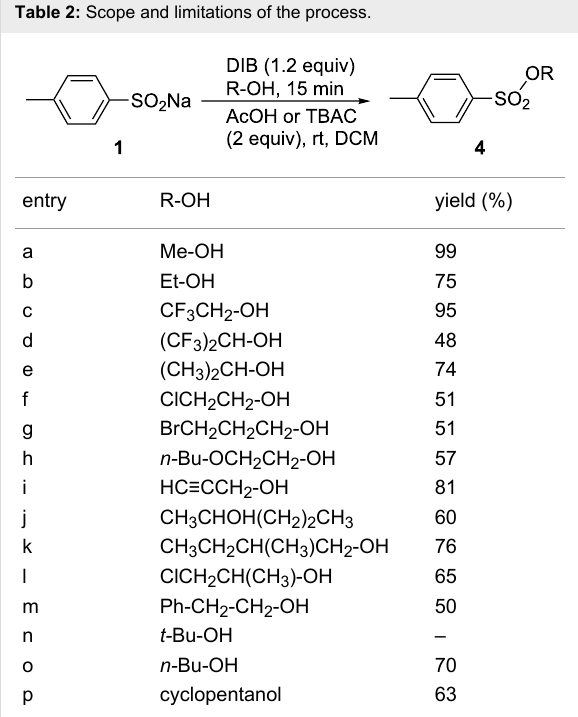
Table 2: Scope and limitations of the